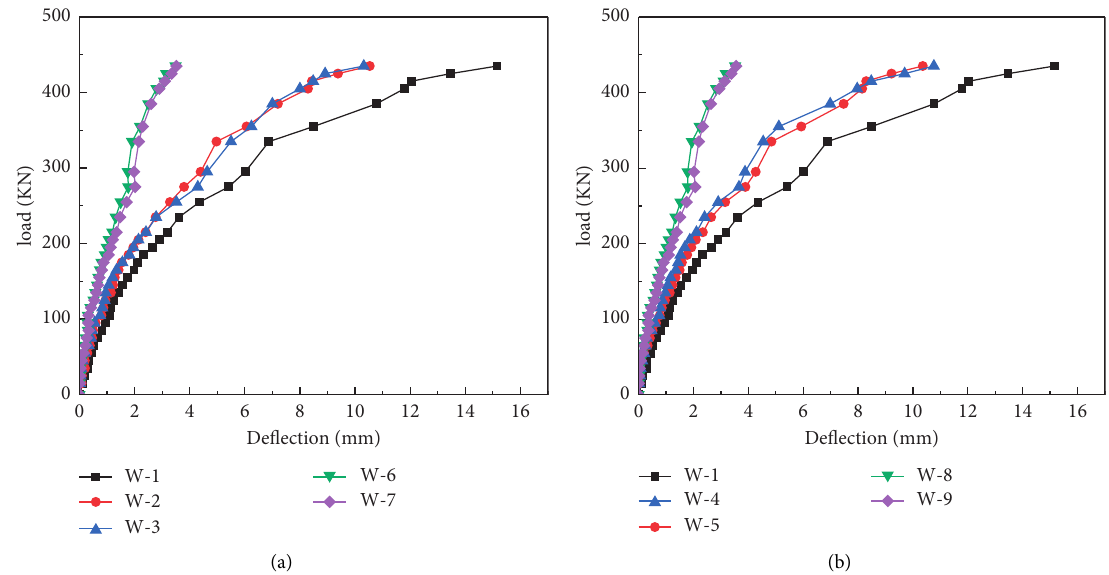
Figure 5: Load-deflection curves of measuring points. (a) x direction. (b) y